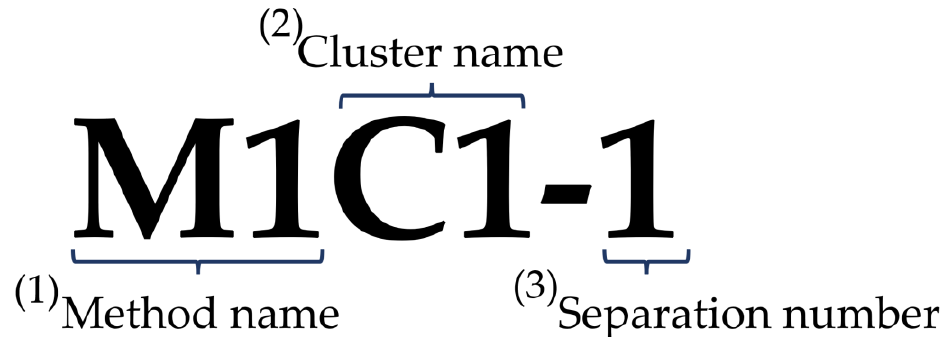
Figure 1. Example relationship of the group for separations.